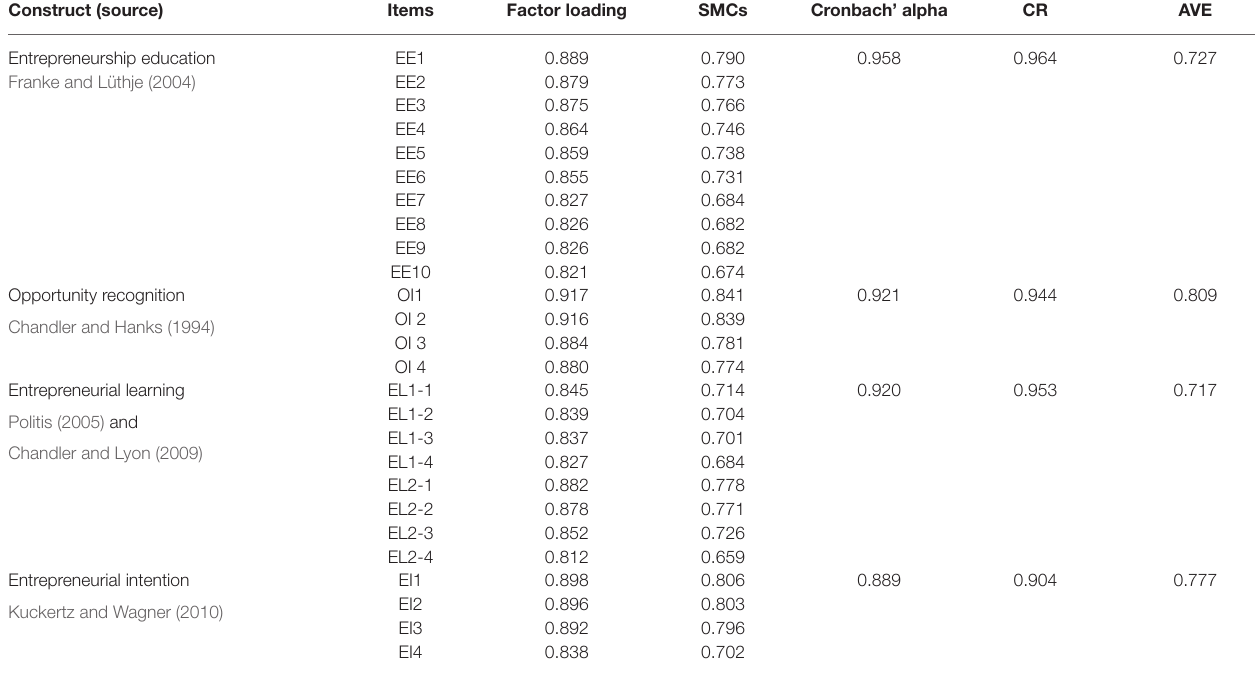
TABLE 1 | Overall reliability of the constructs and factor loadings of indicators. Construct (source) Items